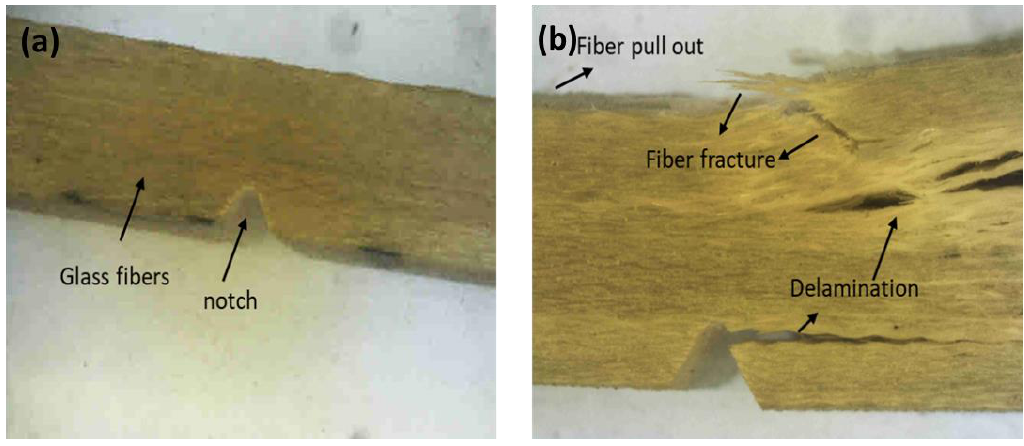
Figure 11. Set A: ( a ) GFRP composite before impact; ( b ) GFRP composite after impact.